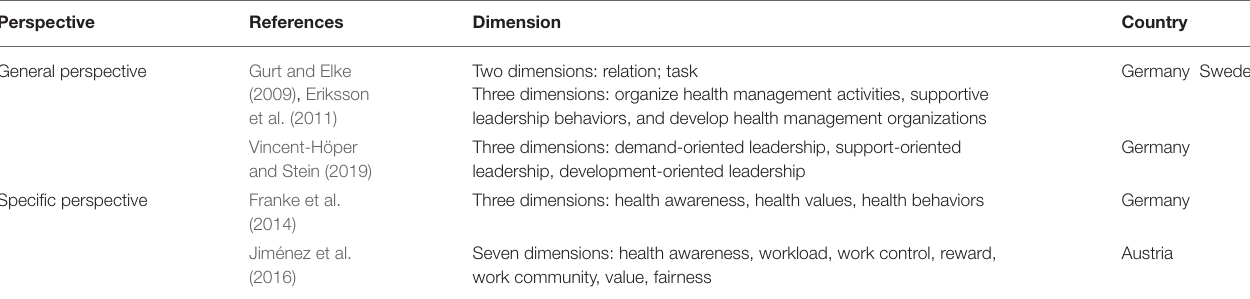
TABLE 2 | Summary of measurements and